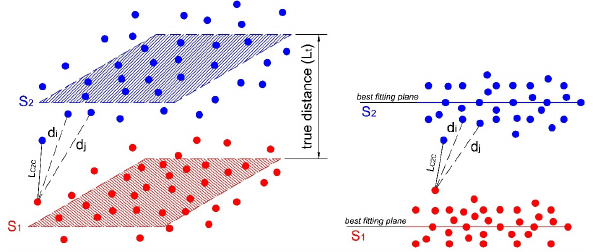
Figure 10: Simplest Cloud-to-Cloud distance. as Cloud-to-mesh distance (C2M). In this case the method com- putes distances between a point cloud and a reference 3D mesh or theoretical model.